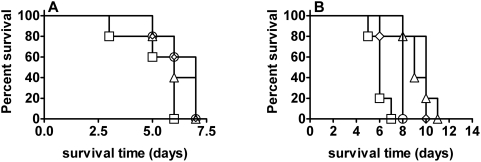
Survival of transposon and deletion mutants of SCHU S4.In A) BALB/c mice were challenged intradermally with 1000 CFU of SCHU S4 (square), ΔFTT0609 (triangle), ΔtolC (circle), or Δrep (diamond). In B) BALB/c mice (n = 5/group) were challenged intradermally with 10 CFU of SCHU S4 (square), ΔFTT1149 (diamond), ΔahpC (triangle), or Δhfq (circle).